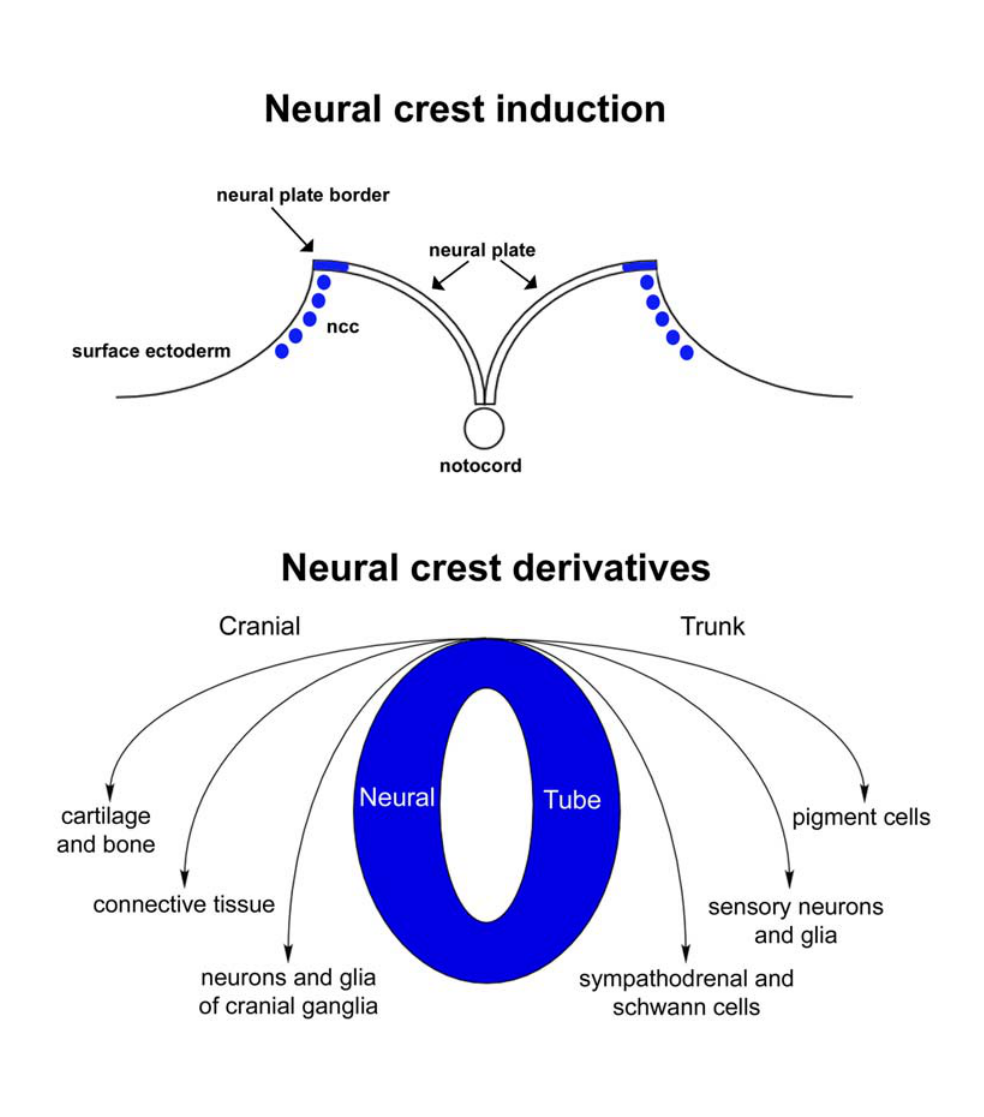
FIGURE 2 . Neural crest cell induction and differentiation. Neural crest cells (ncc; blue circles) are induced at the neural plate border, which demarcates the junction between the neural plate and surface ectoderm. Both the neuroepithelium and the surface ectoderm gives rise to neural crest cells and contact between these tissues is essential for neural crest induction. In the mouse as depicted here, this occurs prior to closure of the neural tube. In contrast, in avian species the neural tube is closed prior to the emigration of neural crest cells. After migrating along stereotypic routes, the cranial neural crest cells differentiate into cartilage, bone, connective tissue as well as neurons and glia of the PNS. In contrast, trunk neural crest cells do not give rise to cartilage or bone rather they differentiate predominantly into the characteristic cells that constitute the trunk